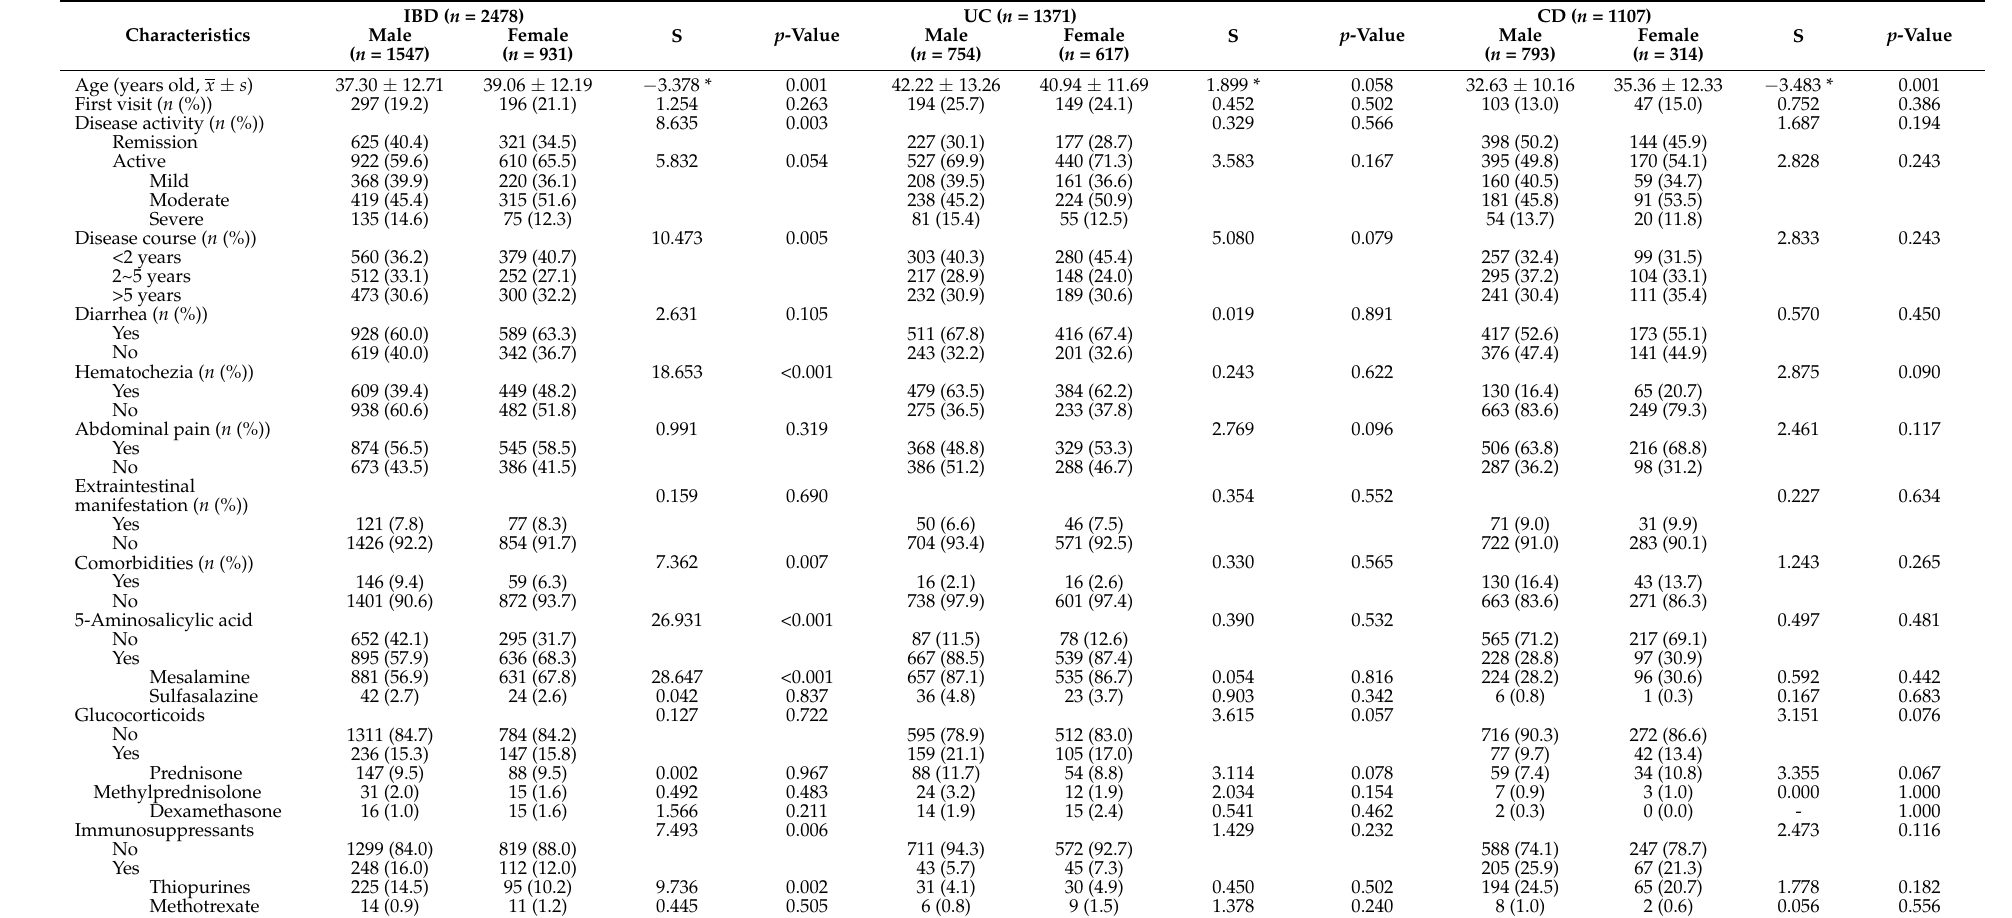
Table 1. Clinical characteristics of IBD patients of different